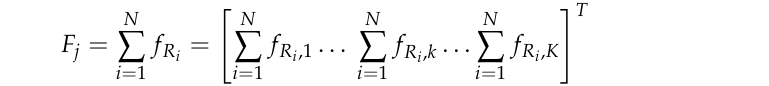
Figure 3. Example of RMAC regions. ( a ) Query image, ( b ) Two first areas of RMAC method, ( c ) Six next areas of RMAC method, ( d ) Twelve last areas of RMAC method.